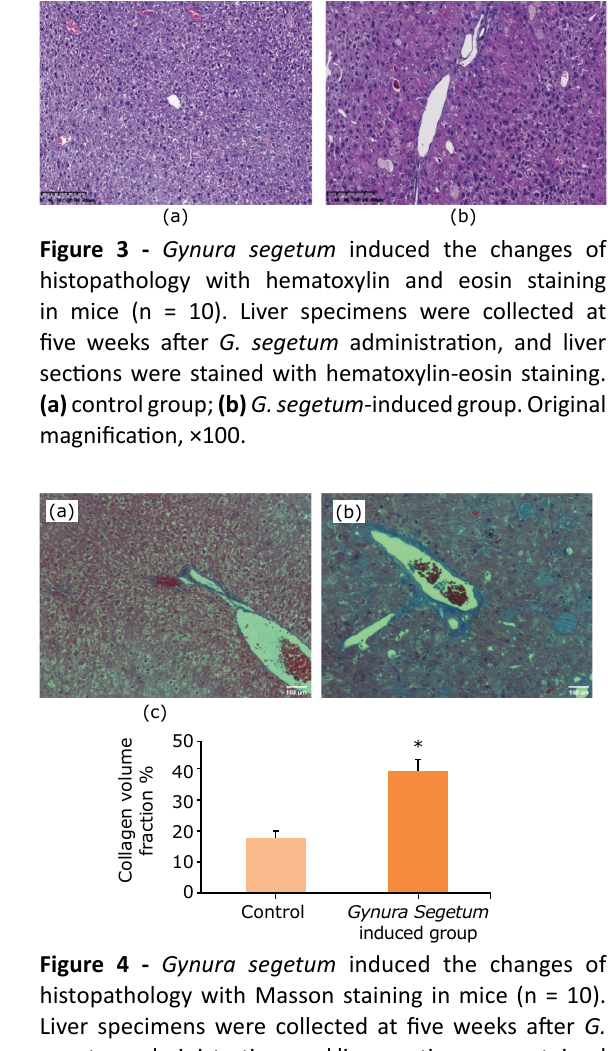
Figure 2 - Gynura segetum induced the increase of serum biochemical indices in mice (n = 10). Blood samples were obtained at five weeks after G. segetum administration: (a) serum ALT; (b) serum AST; (c) serum CHO; (d) serum TG.